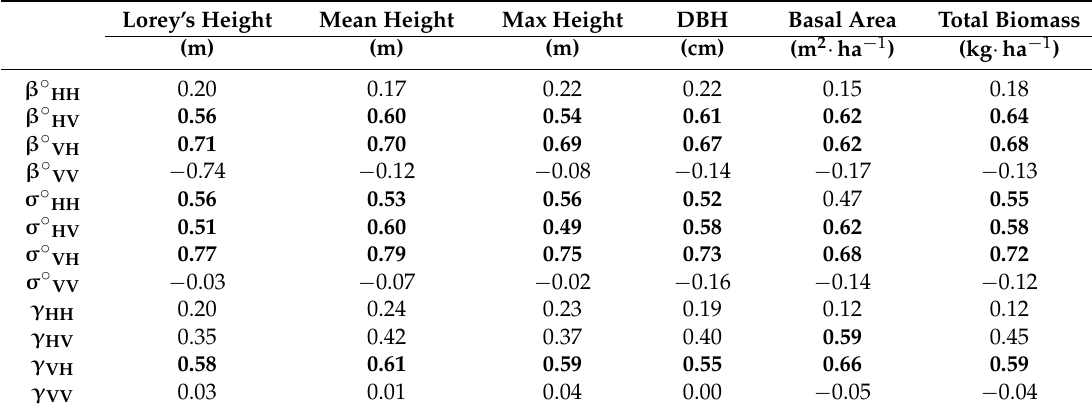
Table 5. Correlation coefficient between structural attributes and backscattering of the Radarsat-2 image FQ5. The highest correlation coefficient values are highlighted ( p < 0.05).